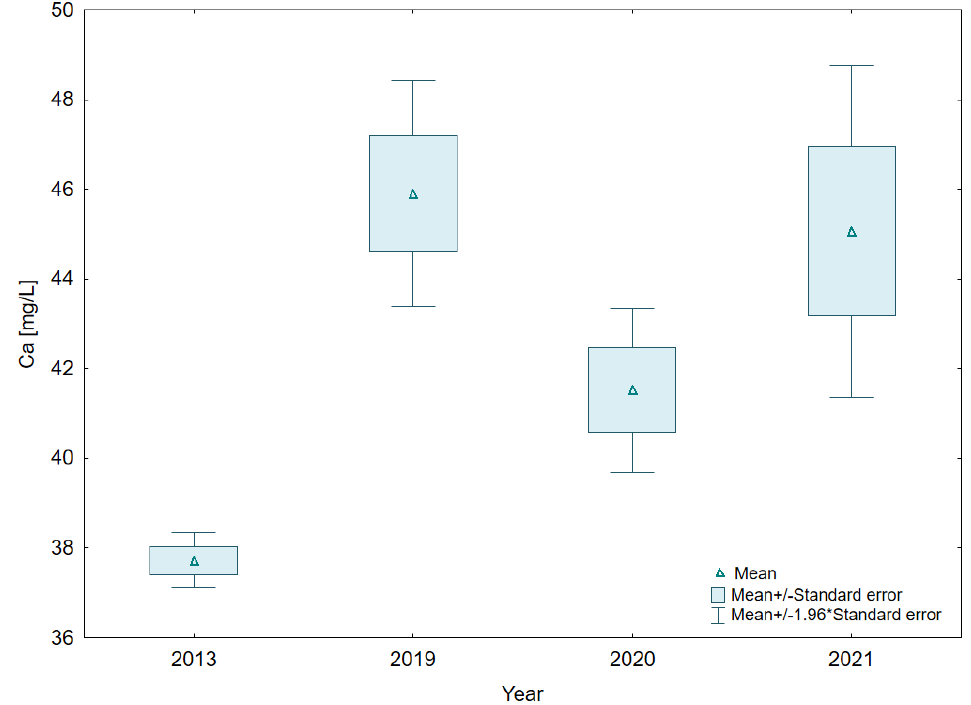
Figure 4. Average annual values of Ca content in the water of Mielenko Lake.